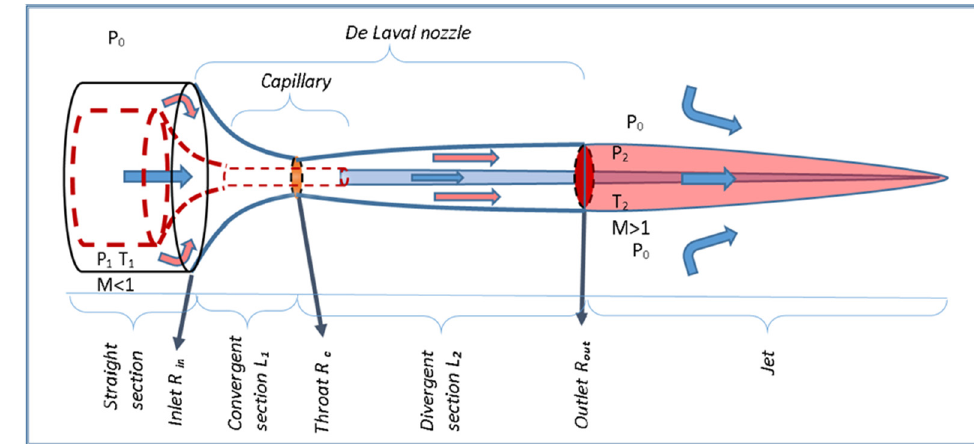
Figure 1. De Laval nozzle geometry components.